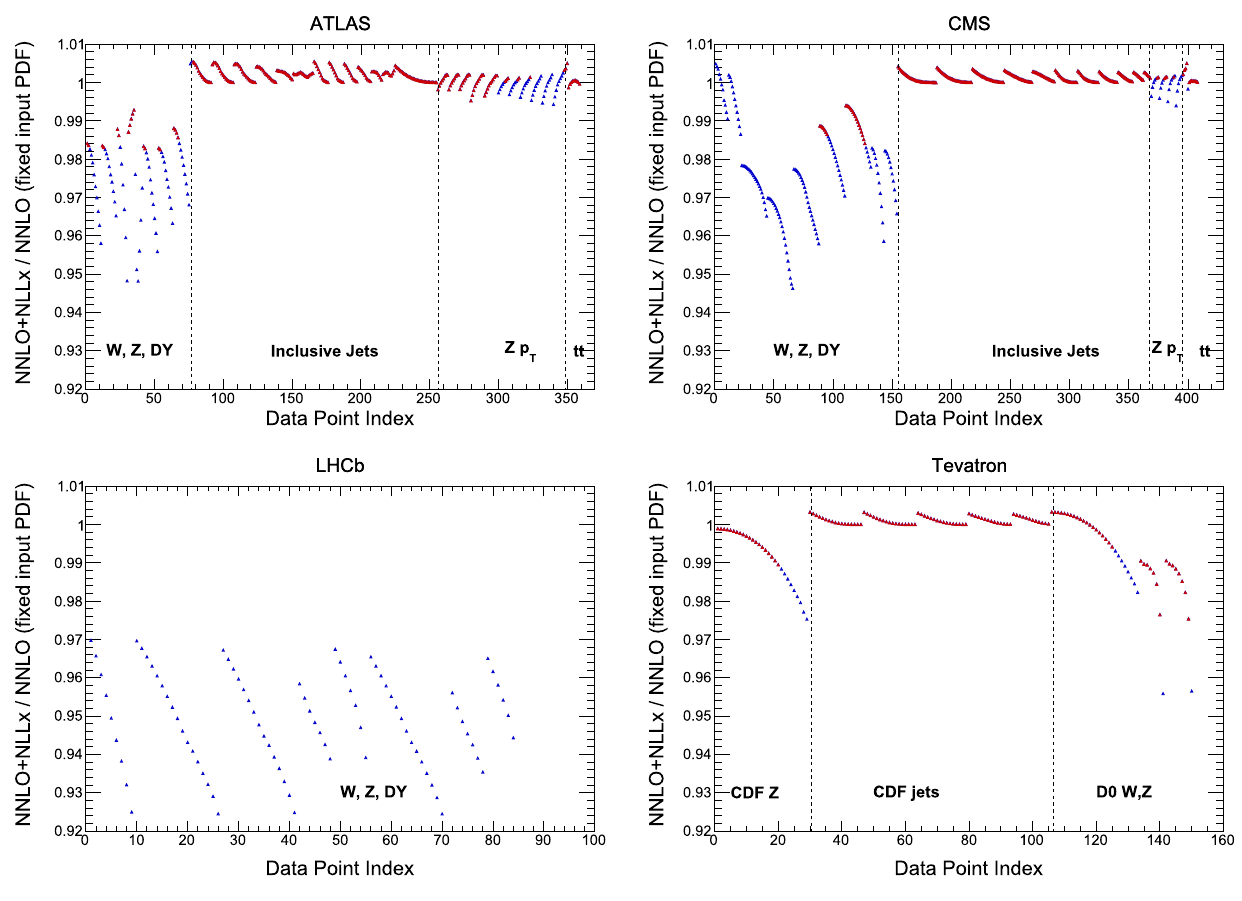
Fig. 6 The ratio of hadronic cross-sections included NNPDF3.1 com- puted using a fixed input PDF at Q 0 = 1 . 65 GeV (in this case NNPDF3.1 NNLO) using either NNLO+NLL x or NNLO theory for PDF evolution, always with NNLO partonic cross-sections. We show the results for ATLAS, CMS, LHCb, and the Tevatron, indicating the